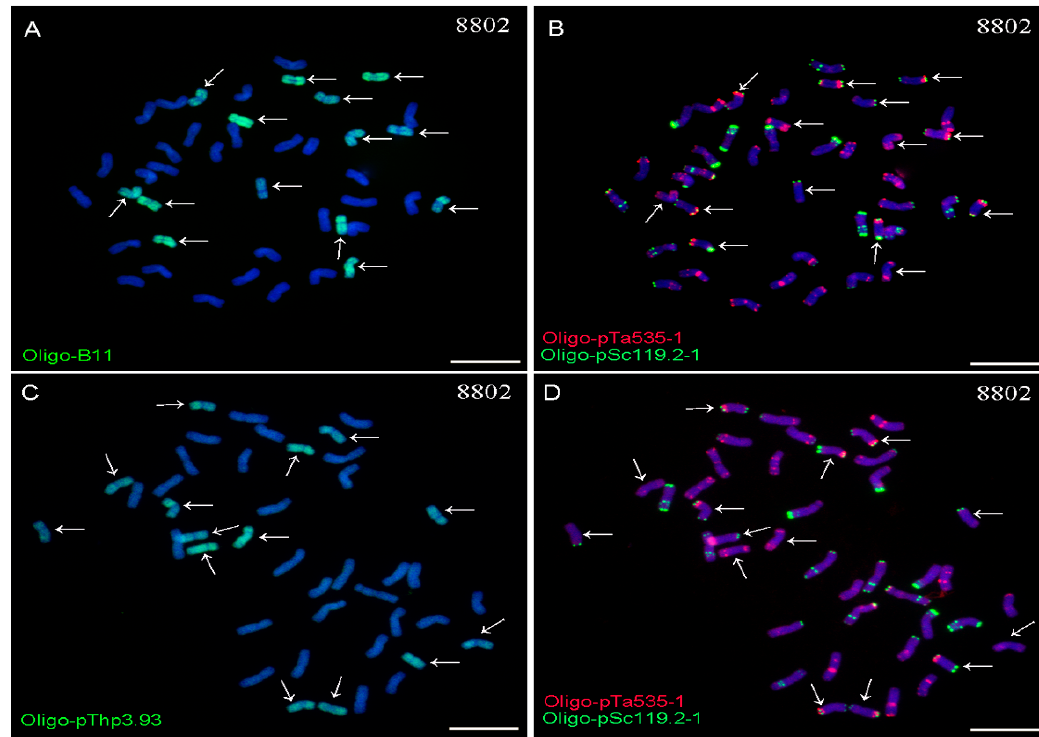
Figure 2. ND-FISH analysis of the root tip metaphase chromosomes of 8802 using the Oligo-B11 (green), Oligo-pThp3.93 (green), Oligo-pTa535-1 (red) and Oligo-pSc119.2-1 (green) as probes. ( A ) and ( B ) are the same cell, and ( C ) and ( D ) are the same cell. Arrows indicate the Th. elongatum chromosomes that carry signals of Oligo-B11 ( A ) and Oligo-pThp3.93 ( C ). Chromosomes were counterstained with DAPI (blue). Scale bar: 10 μ m.